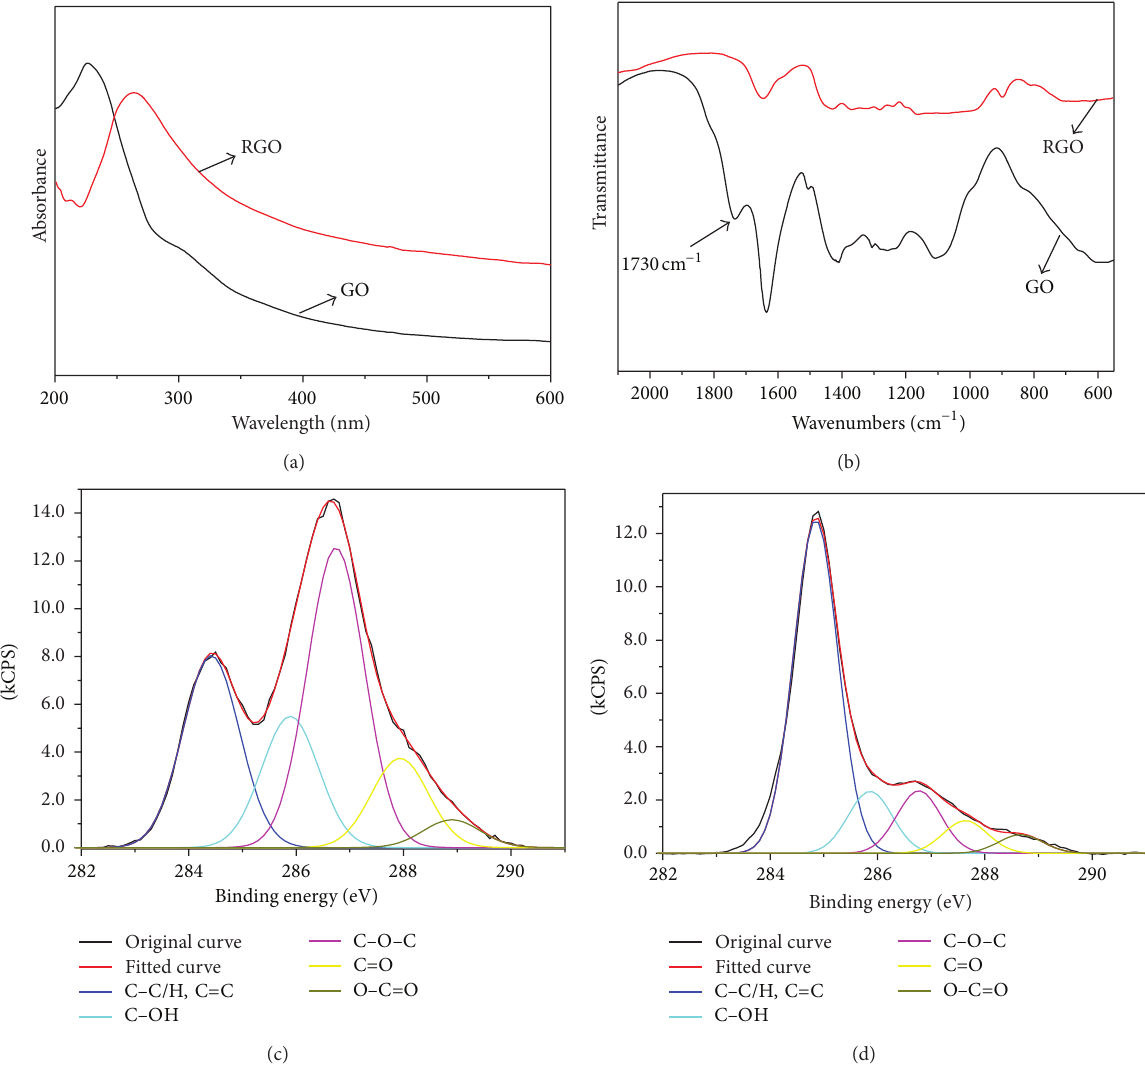
Figure 2: (a) UV-Vis spectra of GO dispersion in ethanol/water before and after 𝛾 -irradiation; (b) FT-IR spectra of starting GO and RGO measured on transmission mode as thin paper form; XPS C1s spectra of (c) starting GO and (d) RGO obtained by irradiating 34 kGy in 70% ethanol/water at 2kGy/h under N 2